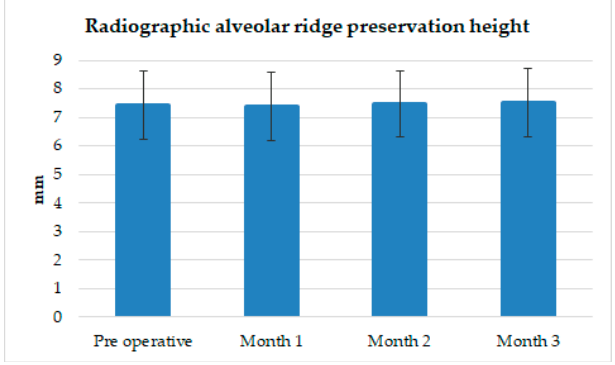
Figure 6. Radiographic measurement of the alveolar ridge height preservation. HA/ β -TCP + collagen is efficacious in preserving the alveolar bone height, with no statistically significant difference between the postoperative measurements and the preoperative measurement ( p > 0.05).